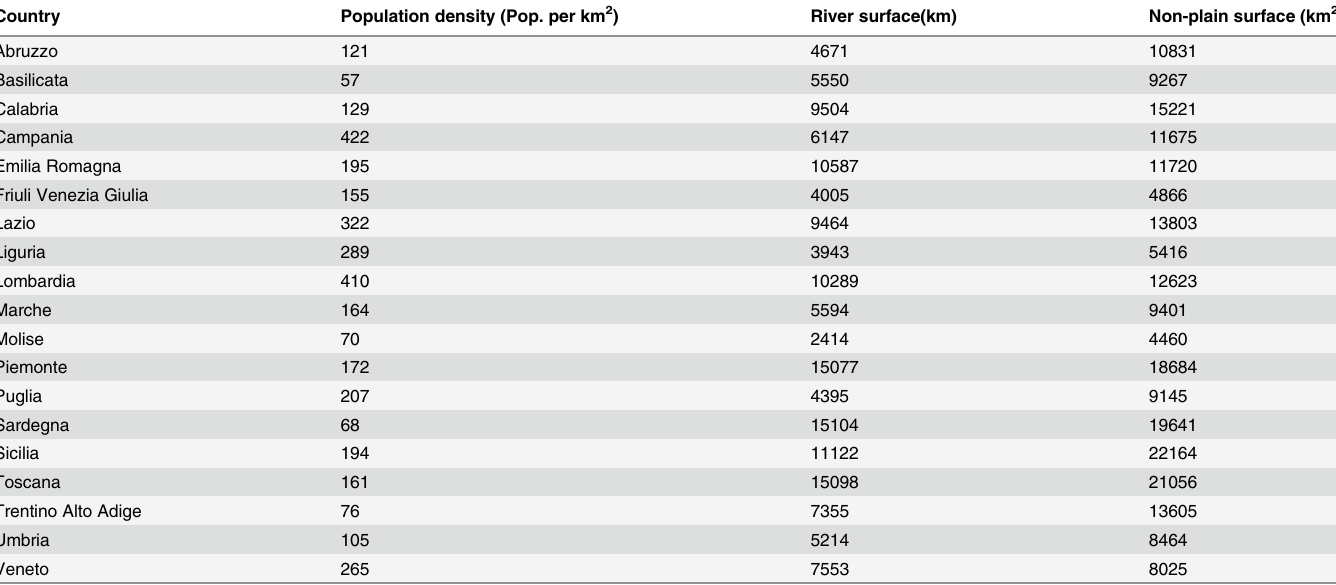
Table 2. Population density, river surface and non-plain surface for each Italian